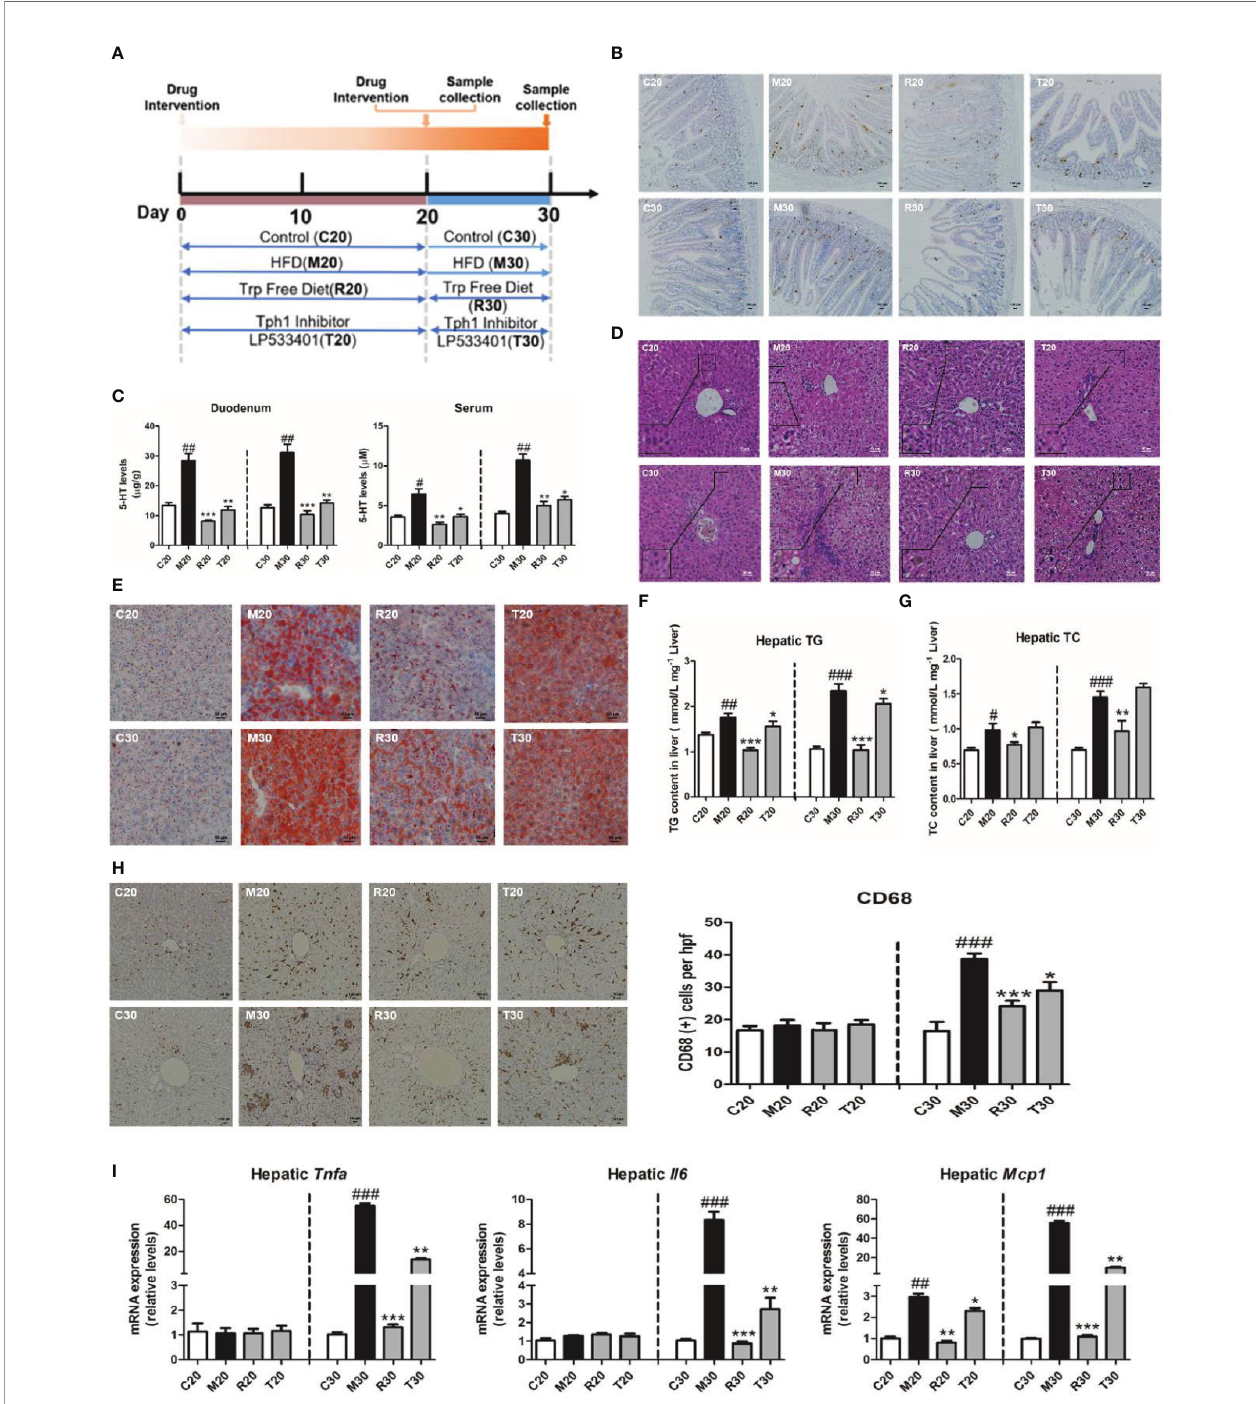
FIGURE 2 | Gut-derived serotonin (GDS) de fi ciency ameliorated the progression of non-alcoholic steatohepatitis (NASH). (A) Experimental procedure. (B) The content of 5-hydroxytryptamine (5-HT) positive cell in duodenum of SD rats. (C) The content of 5-HT in serum and duodenum of SD rats. (D) Hematoxylin – eosin (H&E) staining results of each group of rats (evaluated by 6 experts, ×200). (E) Oil red O staining (small red circle) shows hepatic lipid deposits (×200). Hepatic TG concentrations (F) and TC concentrations (G) in SD rats. (H) The CD68 positive cells content (×100). (I) The messenger RNA (mRNA) expression of genes related to the in fl ammatory response ( Tnf a , Il6 , Mcp1 ) in SD rats fed an HFSD diet on days 20 and 30. The terms C20, C30, and M20, etc., are explained in Animals and Treatments . All data are presented as the mean ± SEM (n = 6). ## P < 0.01, ### P < 0.001, compared with corresponding control group; * P < 0.05, ** P < 0.01, *** P < 0.001 compared with relative model